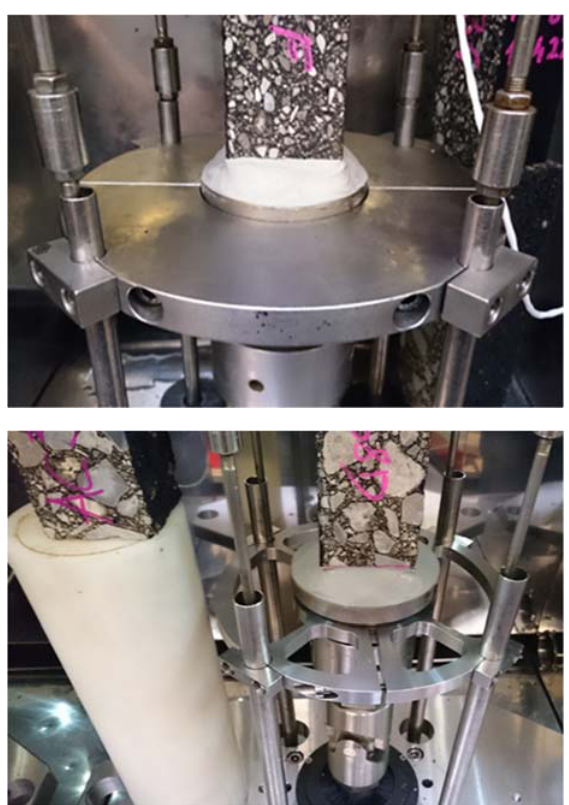
Figure 6. Adapters holding the Invar steel rods in the 2003 (top) and the 2013 device (bottom). To validate the impact of air flow velocity on lag between air and specimen core temperature, an efficient, quick and simple adaption of the 2003 device was set up. Two fans similar to models that are used for cooling central processing units (CPU) of desktop personal computers (PC) were placed on the bottom of the thermal chamber close to the air outlet. Figure 7 shows the setup. The fans’ stream direction was adjusted so that the actual test and the dummy specimen were in the centre of the air stream. 2 different pairs of fan types were used with 3 different settings to study the impact of fan power: a 12 Voltage standard PC fan (air flow velocity max. 2.9 m/s) and a regulable 18‐30 Voltage fan (used settings: 20 V; 5.2 m/s; and 29 V; 7.0 m/s). The thermal program was carried out with one